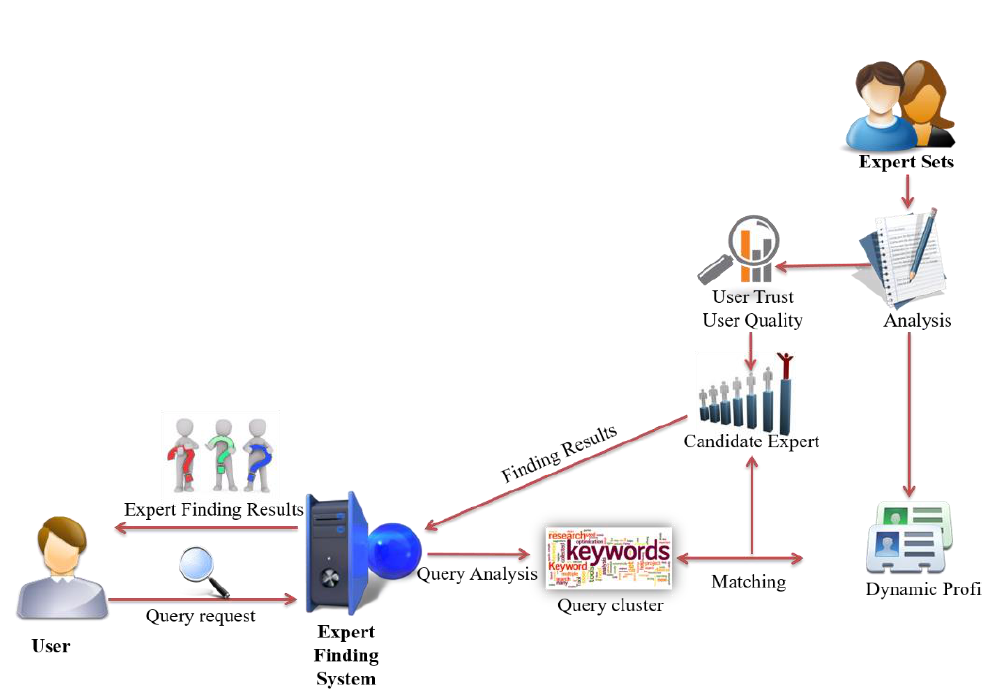
Figure 2. Proposed expert finding process.